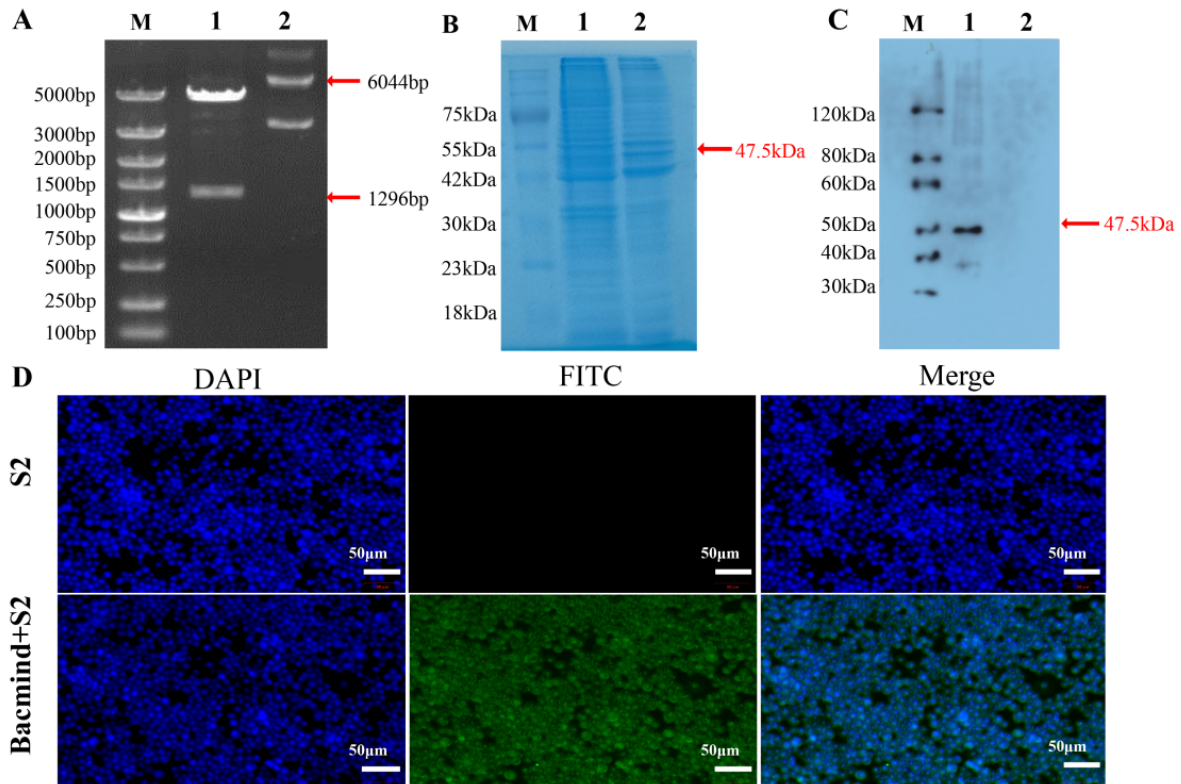
Figure 3. Identification of the recombinant plasmid pFastBac1 -Pocyp4d2 and recombinant protein PoCYP42. ( A ) Restriction enzyme analysis of the recombinant plasmid pFastBac1 -Pocyp4d2 ; M: 5000 bp DNA ladder; 1: Bam HI and Eco R I digestion of the recombinant plasmid pFastBac1 -Pocyp4d2 ; 2: pFastBac1 -Pocyp4d2 recombinant plasmid. ( B ) SDS-PAGE analysis of the recombinant protein PoCYP4D2; M: 75 kDa protein ladder 1: lysed cells’ precipitate; 2: lysed cells’ supernatant. ( C ) West- ern blot analysis of the recombinant protein PoCYP4D2; M: 120 kDa protein ladder 1: lysed cells’ supernatant; 2: lysed cells’ precipitate. ( D ) Immunofluorescence identification of PoCYP4D2 recom- binant protein in S2 cells after 72 h (200×).